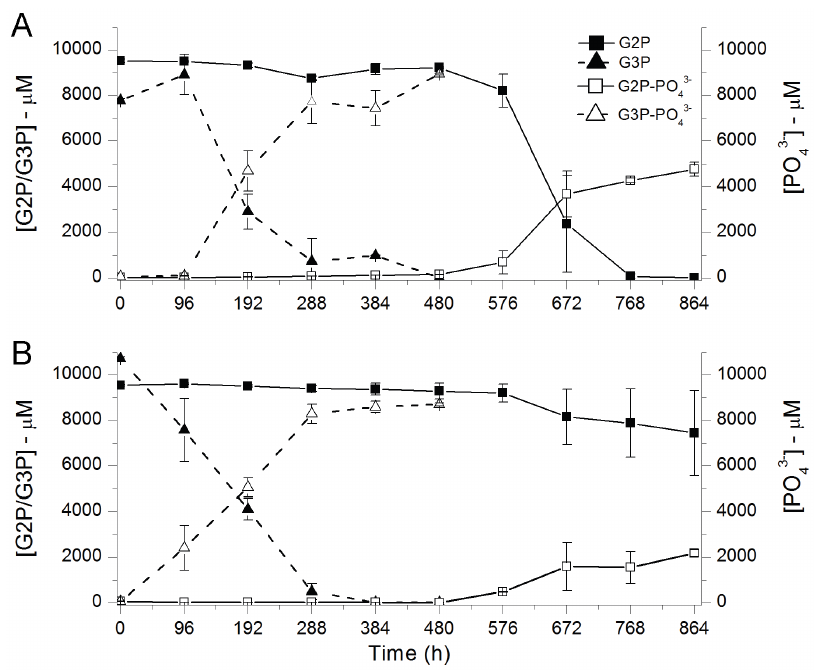
Figure 3. Organophosphate and phosphate measurements. Sediment slurry incubations conducted at (A) pH 5.5 and (B) pH 6.8. Solid lines connect time points in G2P treatments and dashed lines connect time points in G3P treatments.